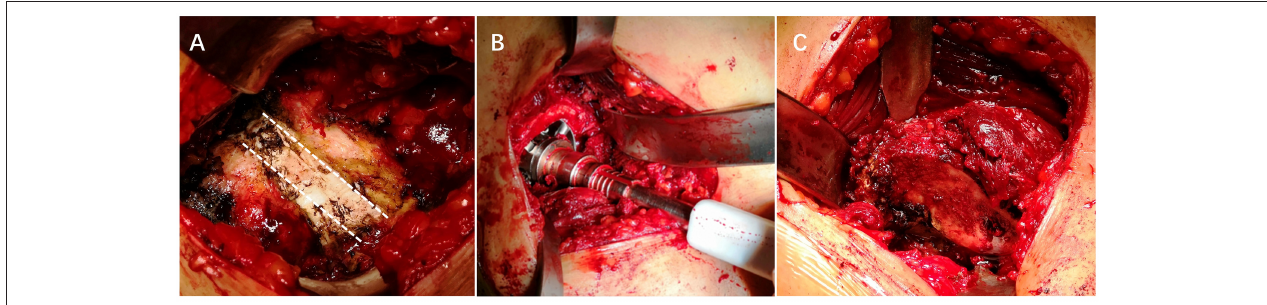
FIGURE 1 | Intraoperative photographs of a fused hip. (A) Intraoperative photograph of the site of the fusion. (B) Reaming the acetabulum. (C) Exposing the proximal femur.